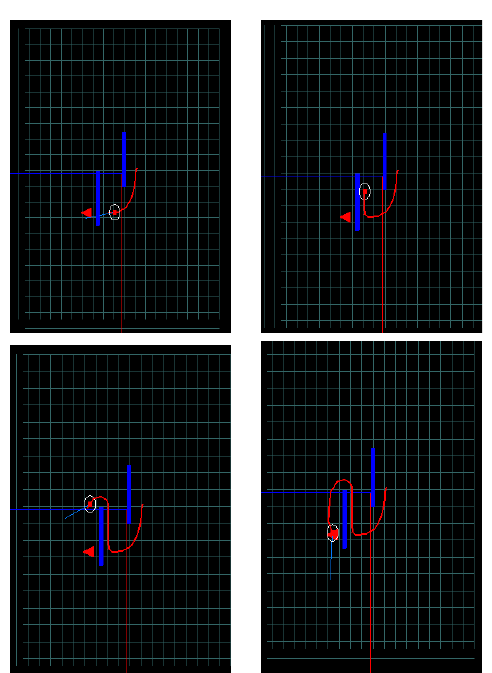
Figure 6. Sequence of images of the learned trajectory using the IRL schema. The thick (red) line is the learned